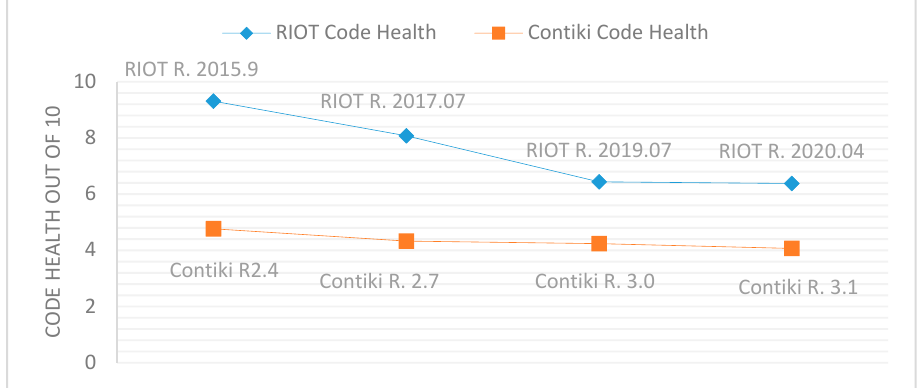
Figure 9. Code Health evolution of RIOT and Contiki releases.